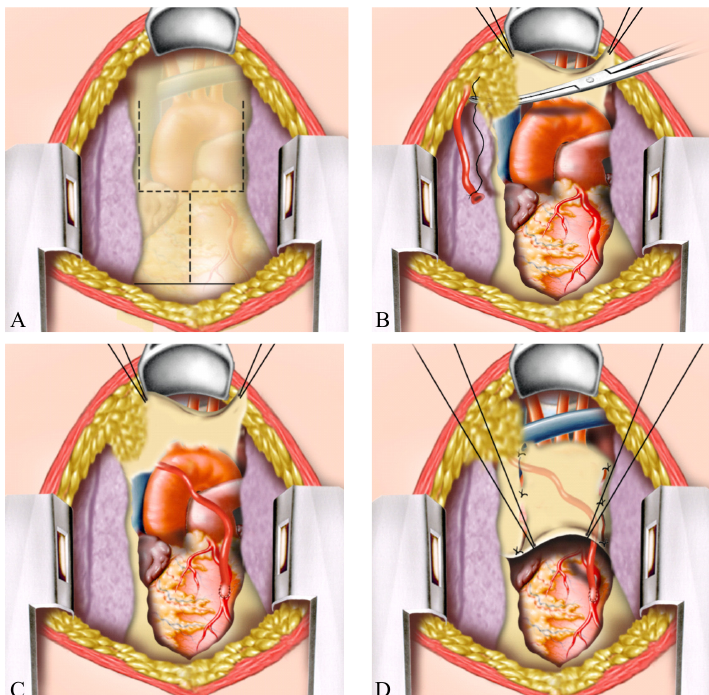
Fig. 1 - (A, B, C and B) Drawing showing details of the opening of the pericardium and tunneling through the mediastinal fat to protect the RITA